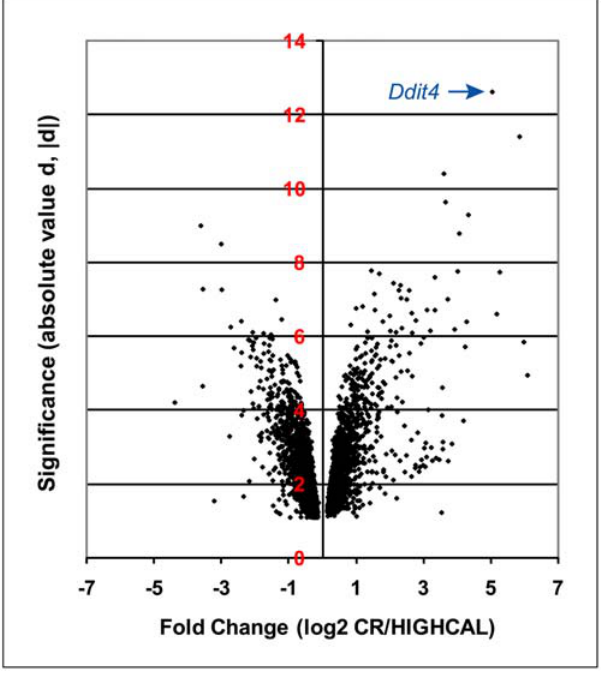
Figure 1. Plot of significance versus fold change of all significant genes. Plot of significance (absolute value of d, |d|) versus log2 fold change, for all 3,855 genes called significant at q , 0.1. Ddit4 , the gene with the highest significance score, is shown at upper